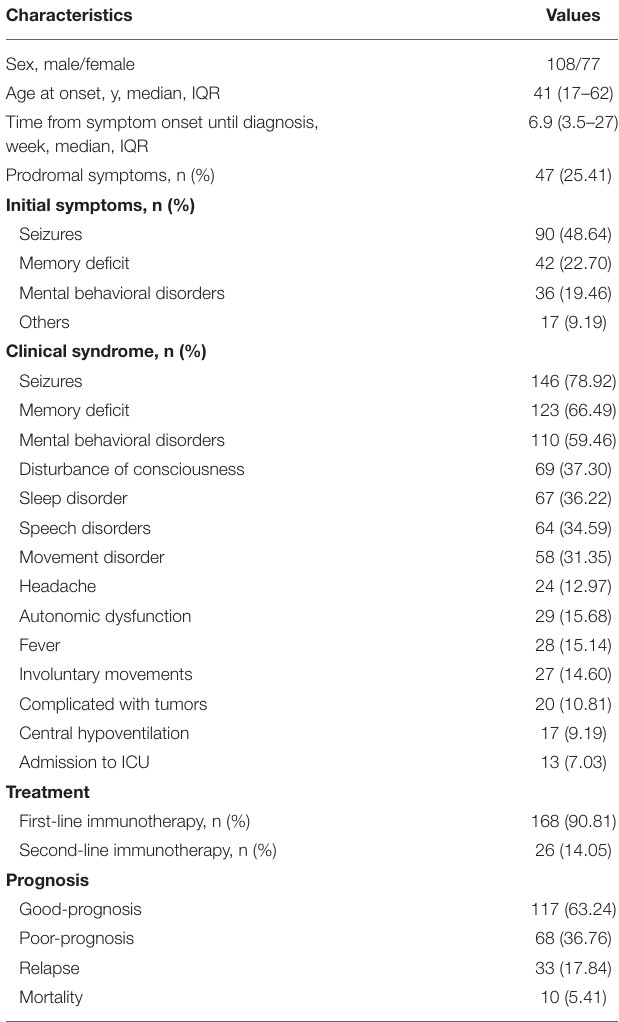
TABLE 1 | Clinical features of patients ( n =